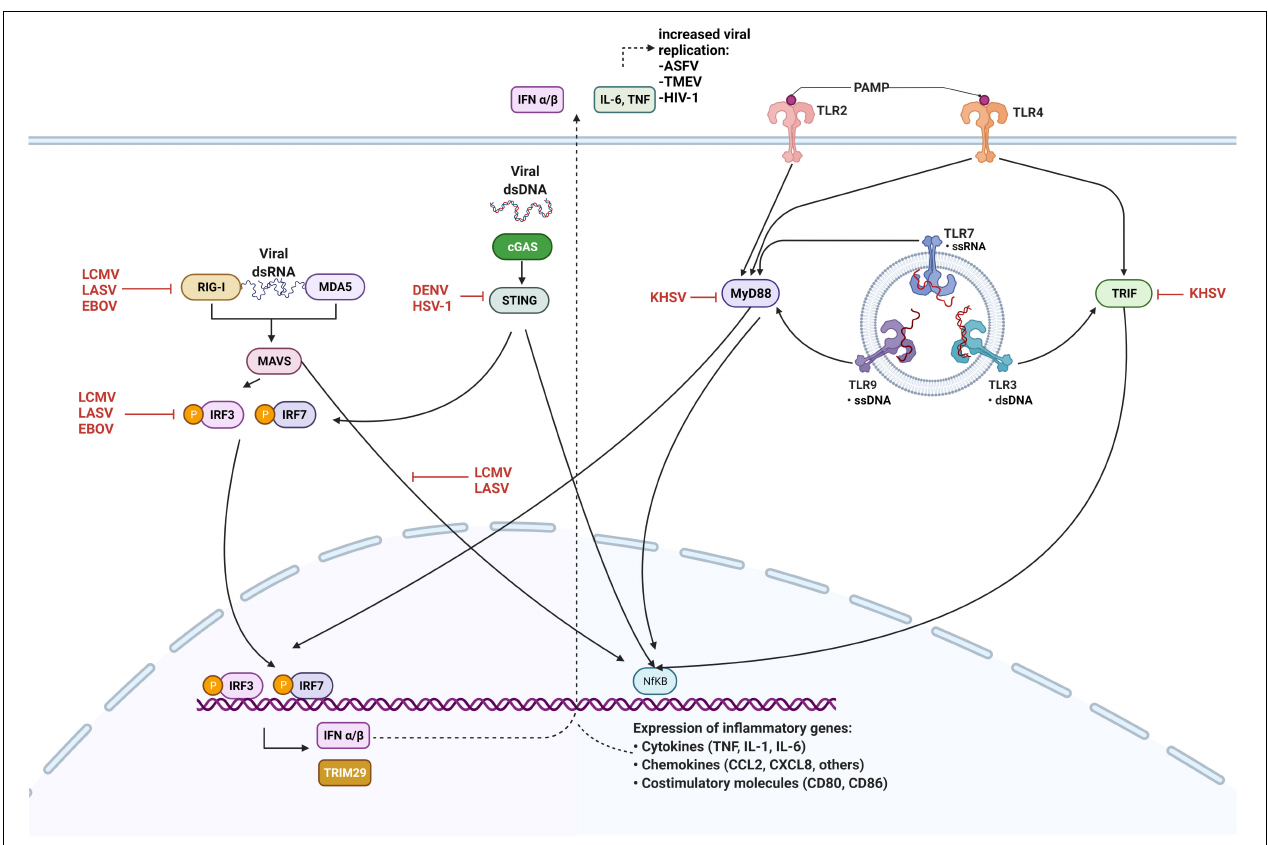
FIGURE 1 | Innate immune antagonism by viruses. Retinoic acid-inducible gene I (RIG-I) and melanoma differentiation-associated gene 5 (MDA5) detect cytosolic viral RNA and interact with MAVS, cGAS binds DNA to activate the STING pathway. Viral PAMPs interact with Toll-like receptors expressed on the plasma membrane and in the endosome, leading to the activation of MyD88 and TRIF. Detection of viral nucleic acid triggers downstream signaling culminate in the phosphorylation and activation of interferon regulatory factors (IRFs) 3 and 7, and expression of type I interferons (IFN) together with NF-kB. Viral proteins inhibit innate sensing and signaling by interacting with cellular proteins at several steps, as shown. Black arrows indicate pathways that lead to the activation of downstream molecules, while red blunted arrows indicate steps that are inhibited. Figure created with licensed Biorender